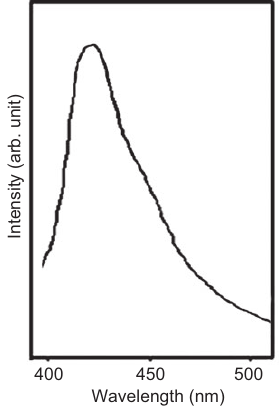
Figure 4 EDX pattern of the PbS nanocrystals synthesized with 1 m of thiophenol.